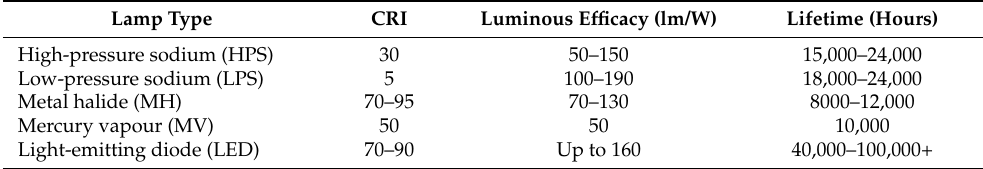
Table 1. Characteristics of main road lighting